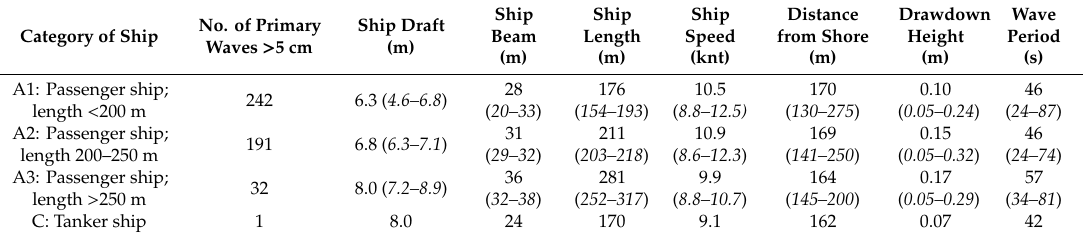
Table 1. Summary of field measurements of primary waves for di ff erent ships generating such waves. Given values, except the number of ship passages and recorded primary waves, are average values and within brackets are the minimum and maximum values given. Statistics of ship parameters only include those ship passages resulting in the registration of a primary wave